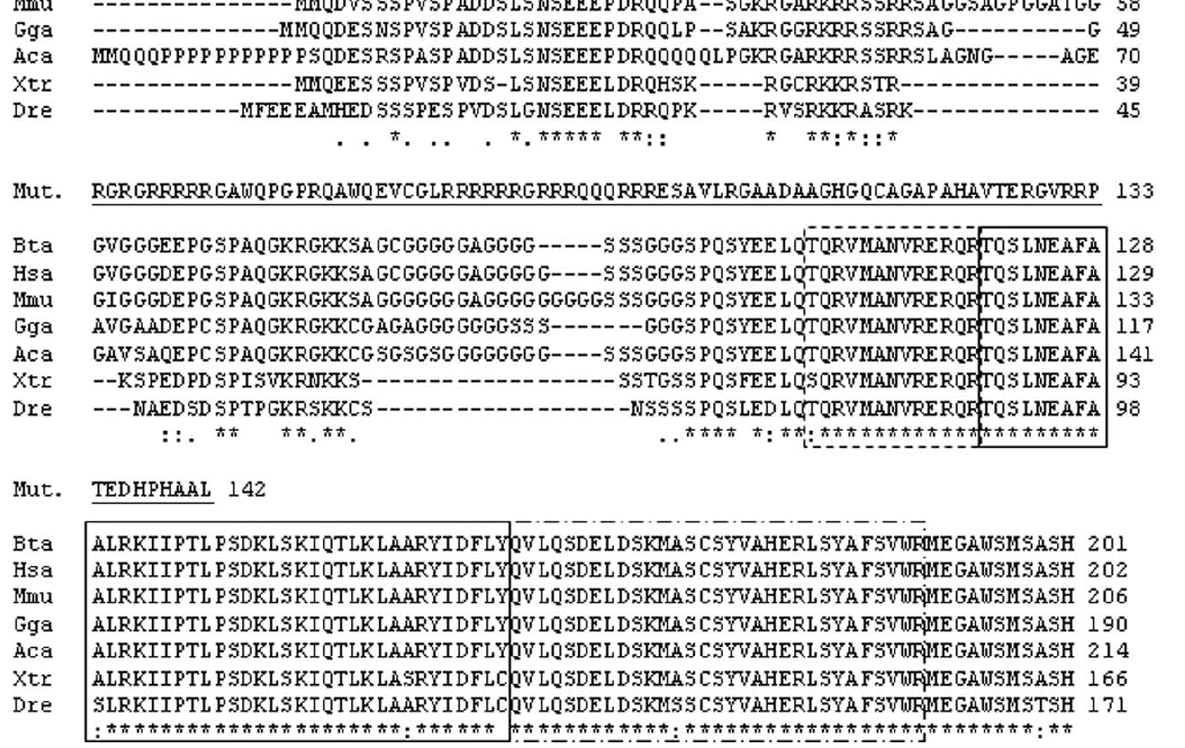
Figure 5. Characterization of the TWIST1c.148_157dup mutation. (A) TWIST1 gene’s organization scheme; (B) DNA sequencing chromatograms showing the c.148_157dup mutation of type 2 scurs affected animals and the wild type allele; (C) putative p.A56RfsX87 mutated protein and multispecies alignment of the TWIST1 protein sequence using CLUSTALW [21]. Cattle (Bta), human (Hsa), mouse (Mmu), chicken (Gga), anolis (Aca), xenopus (Xtr) and zebrafish (Dre) sequences accession numbers are respectively DAA30767, NP_000465, AAH33434, NP_990070, DAA06059, AAH74558, ABC73066 in Genbank. The frame-shift change in the bovine p.A56RfsX87 mutated protein (Mut.) is underlined. The basic, helix-loop-helix and tryptophan–arginine domains are respectively highlighted with dashed, solid and mixed dashed boxes [22]. doi:10.1371/journal.pone.0022242.g005 PLoS ONE | www.plosone.org